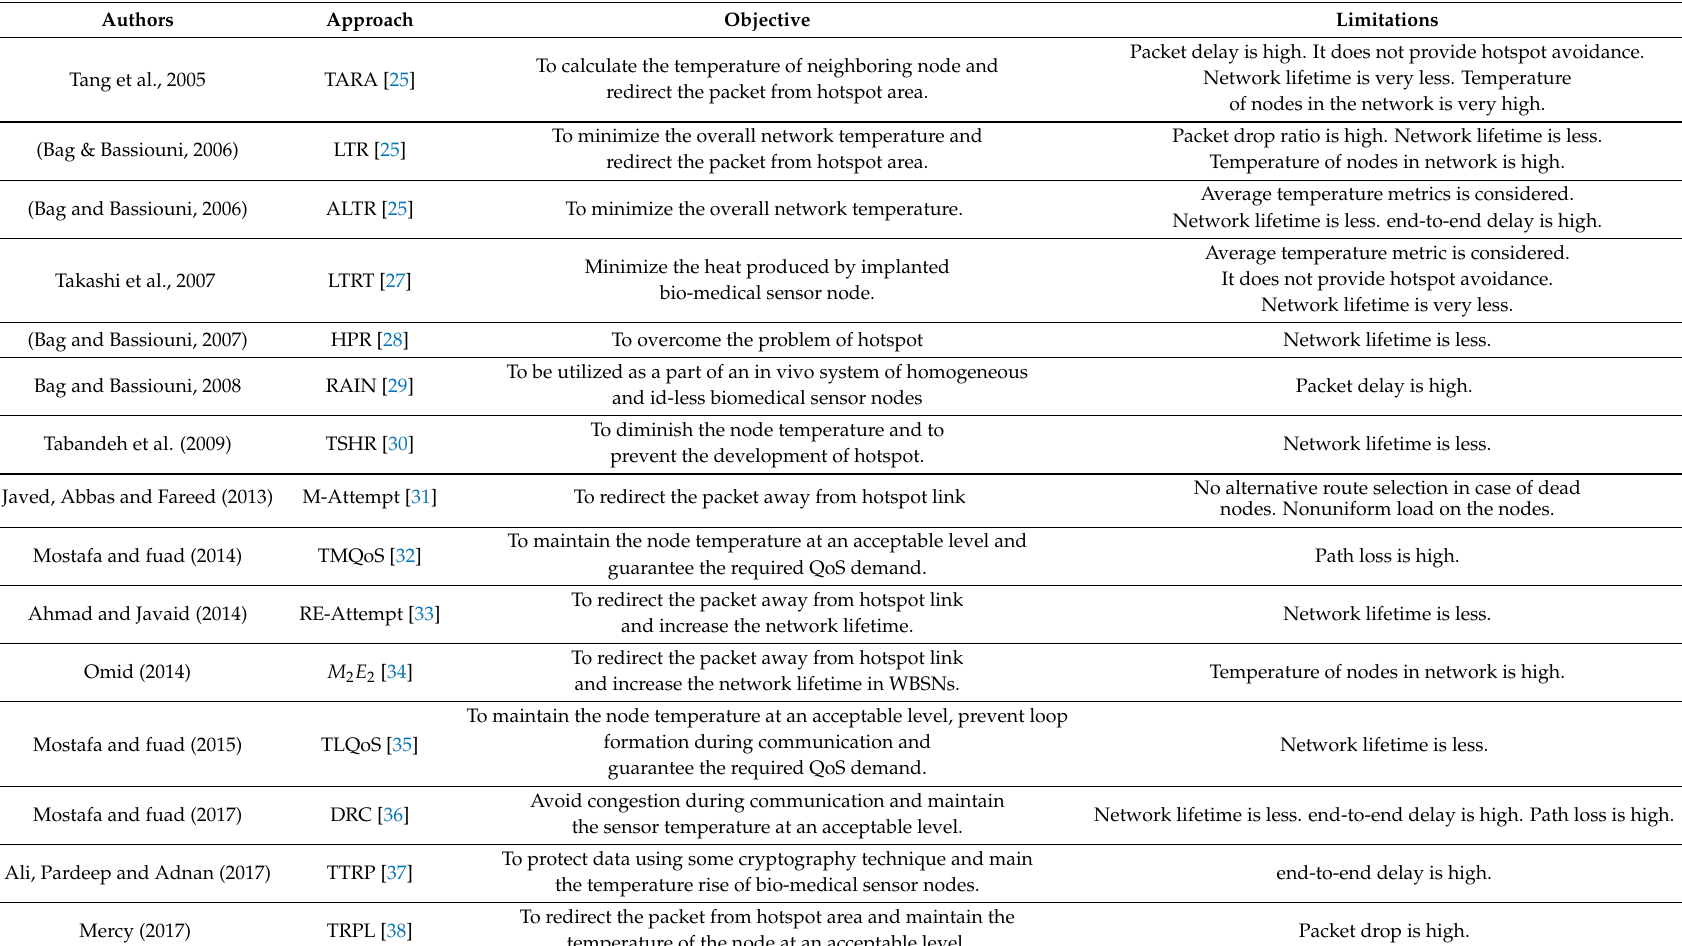
Table 1. Critical analysis of thermal-aware routing